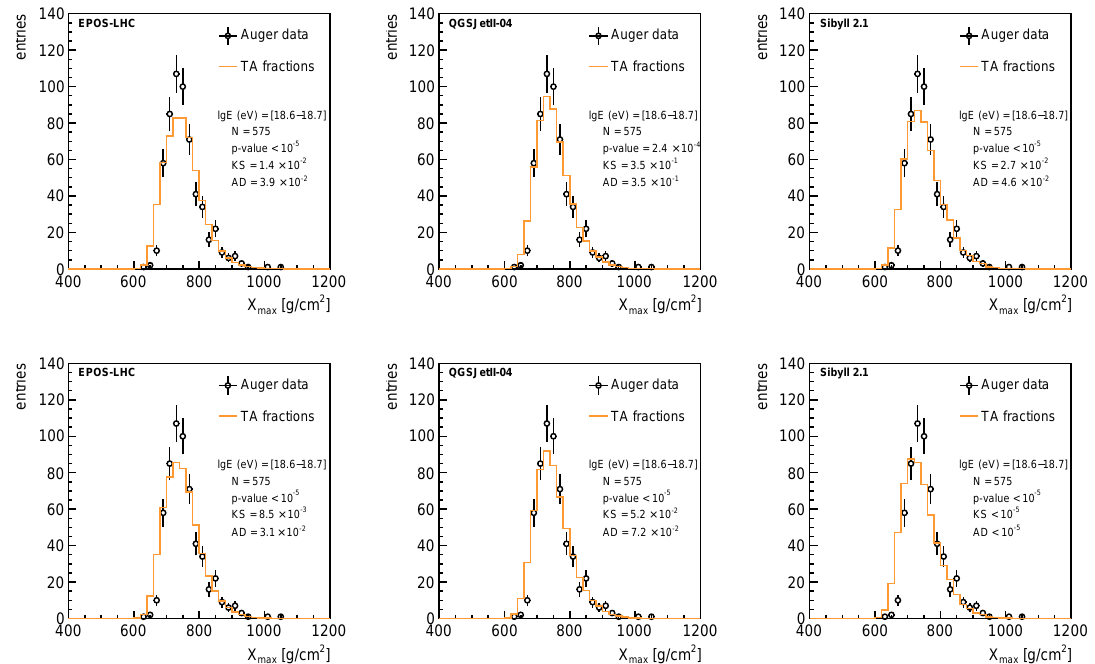
→ Auger max in the energy interval